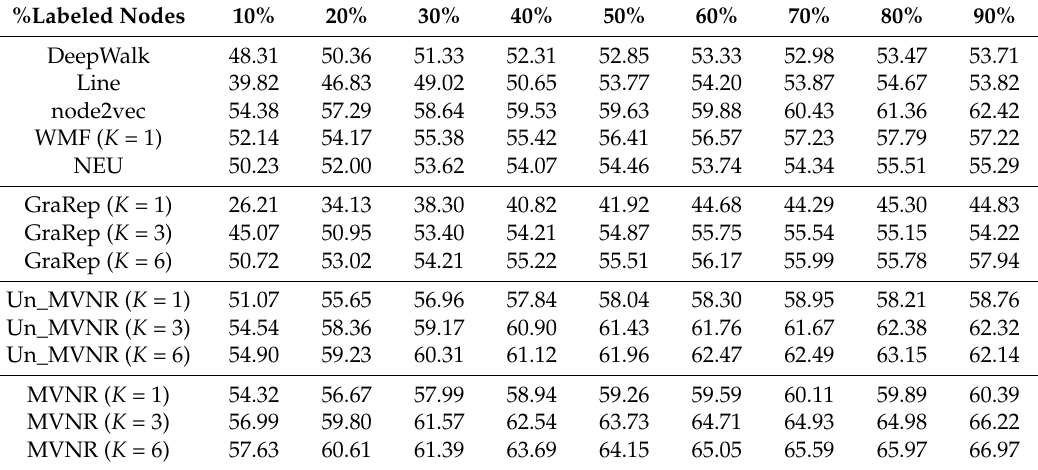
Table 3. Accuracy (%) of vertex classification on